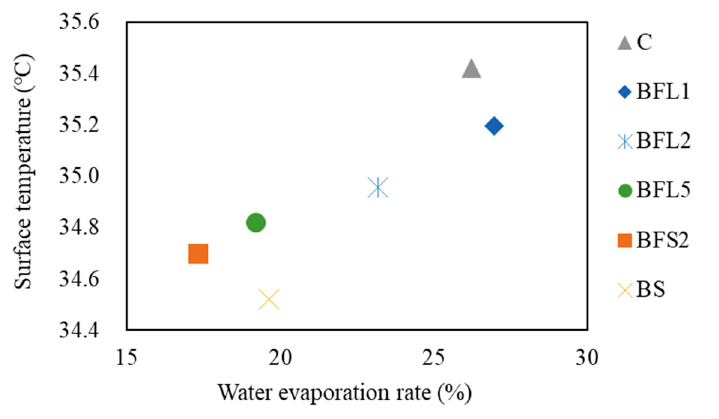
Figure 11. Relation between the surface temperature and the water evaporation rate.